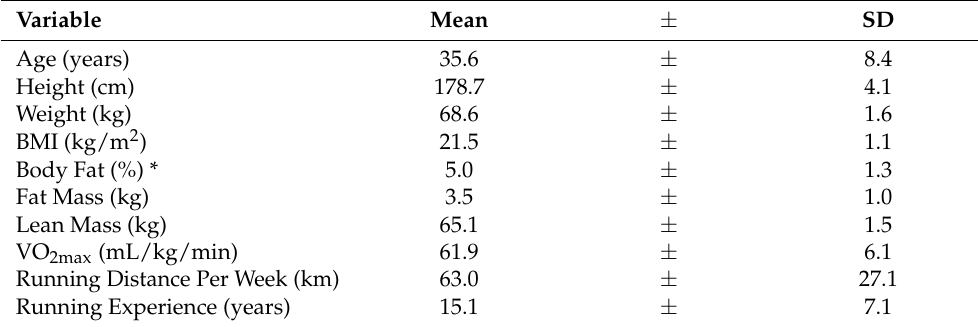
Table 1. Subject Characteristics ( n =